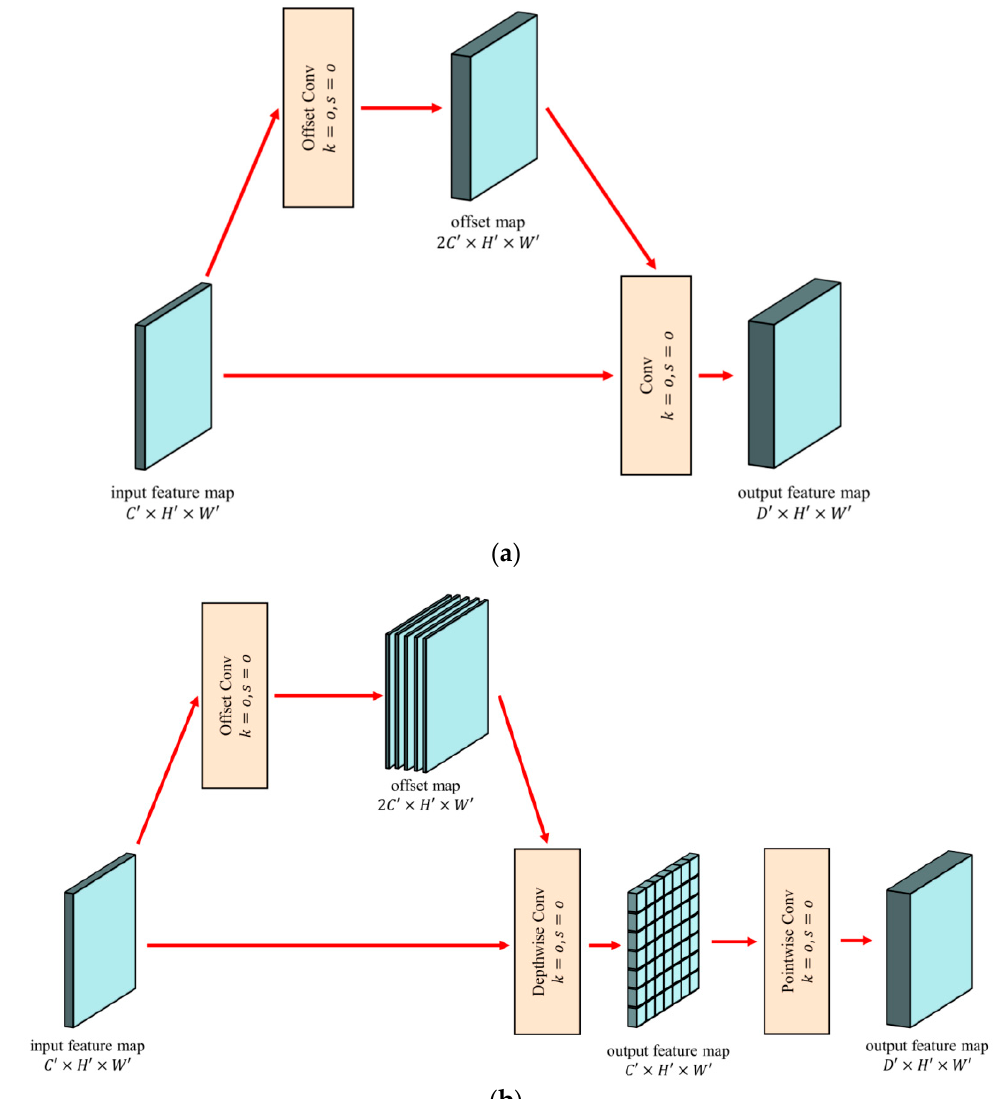
Figure 6. Comparison of vanilla deformable convolution and depthwise separable deformable convolution: ( a ) vanilla deformable convolution; ( b ) depthwise separable deformable